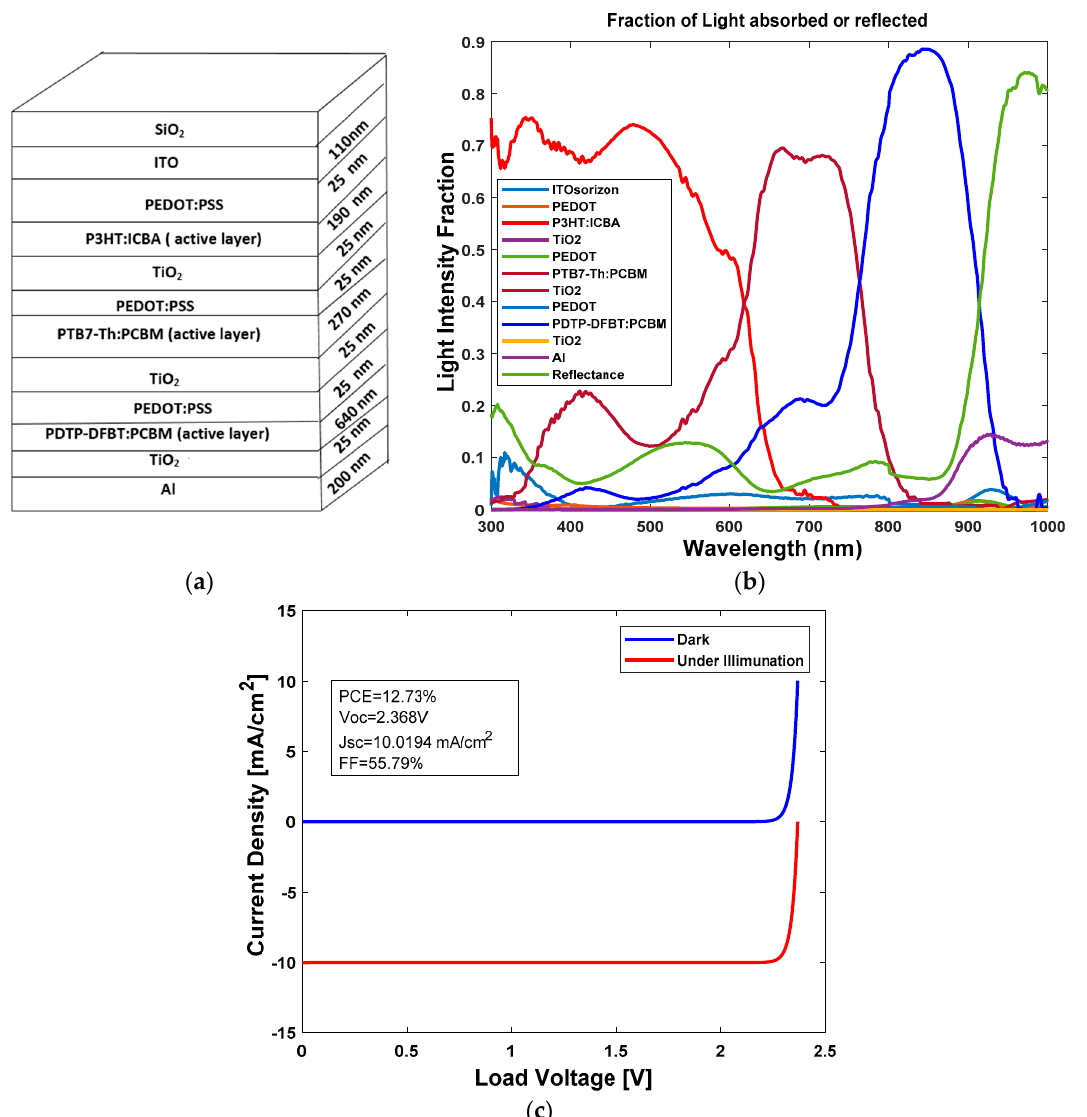
Figure 3. ( a ) Stack diagram; ( b ) variation of light intensity versus wavelength; and ( c ) J–V characteristics of three-junction organic solar cell (OSC) with front P3HT:ICBA, middle PTB7- of three-junction organic solar cell (OSC) with front P3HT:ICBA, middle PTB7-Th:PCBM and rear Th:PCBM and rear PDTP-DFBT:PCBM active layers. PDTP-DFBT:PCBM active